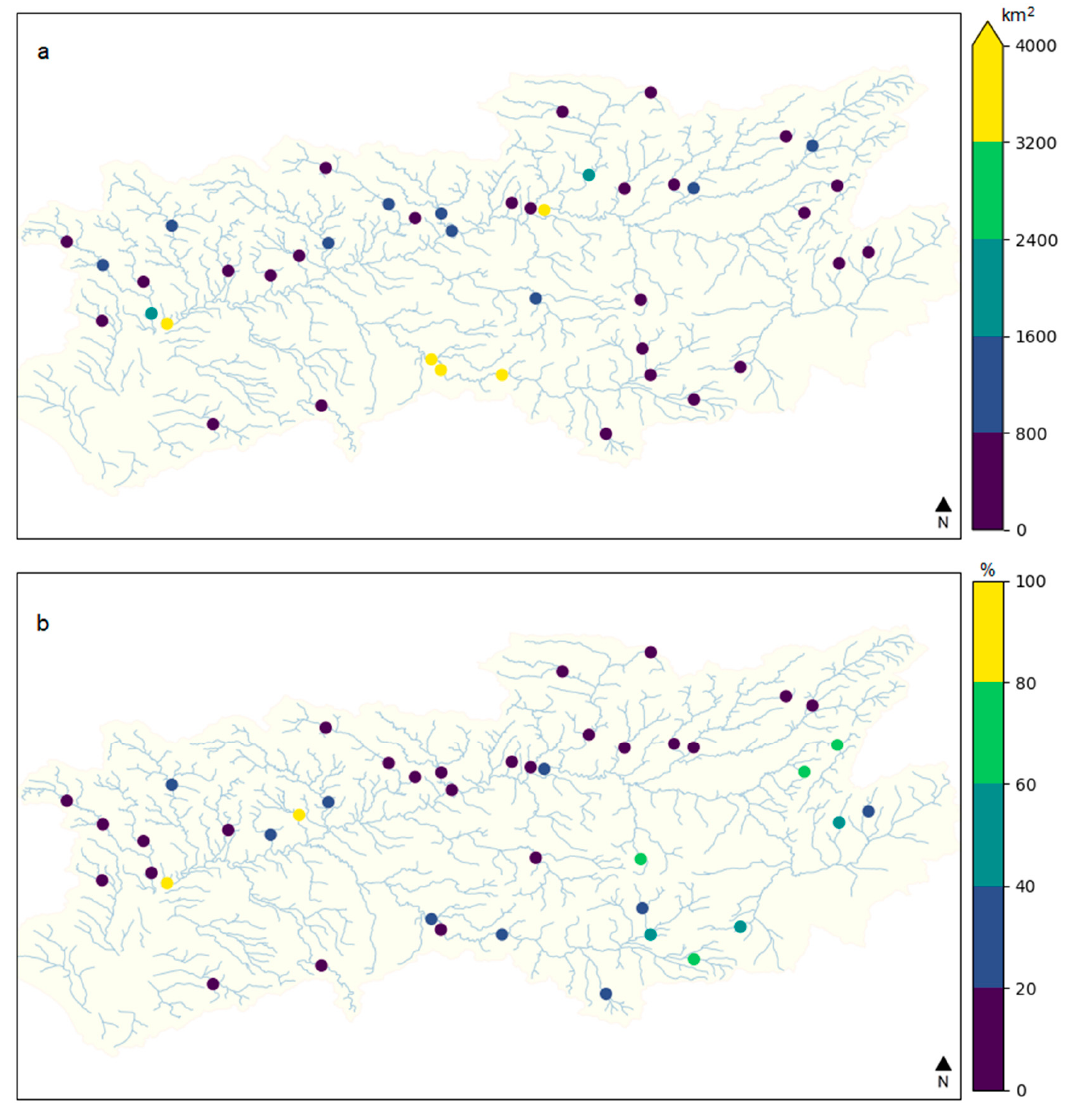
Figure 2. ( a ) Catchment area of each station in km 2 , capped at 4000 km 2 . ( b ) Percentage of permeable soil in the catchment basin of each station.